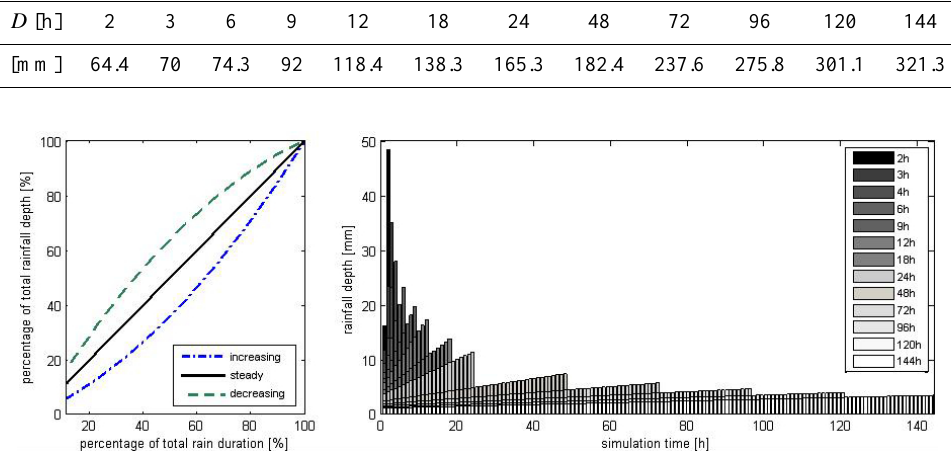
Table 2. Design storm durations ( D ) and associated rain sums of the Gepatschalm catchment (recurrence interval of T = 5000years).